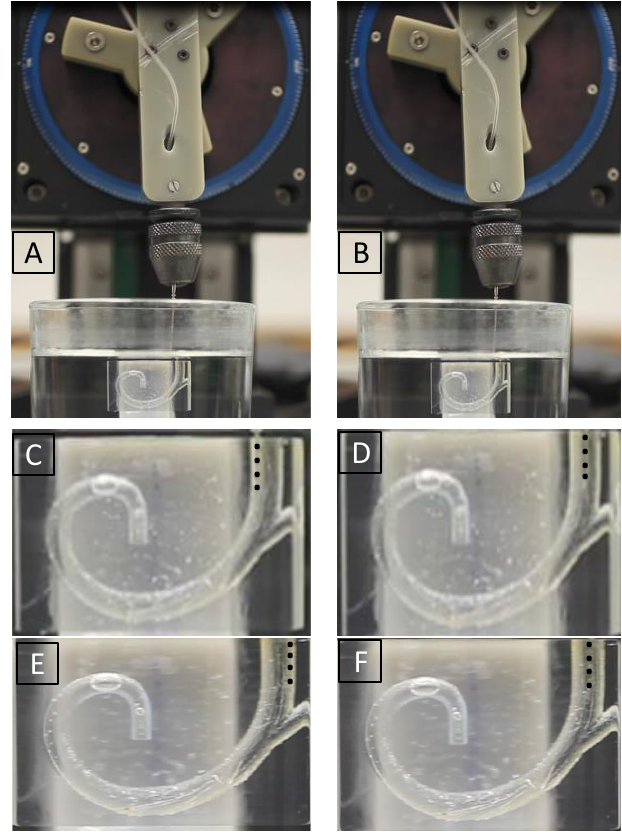
Figure 9. Real-time correction of insertion trajectory. ( A ) Experimental setup with medial trajectory insertion, ( B ) experimental setup with correction to middle trajectory, ( C ) close-up of medial trajectory insertion, ( D ) correction of medial trajectory, ( E ) lateral trajectory, ( F ) correction of lateral